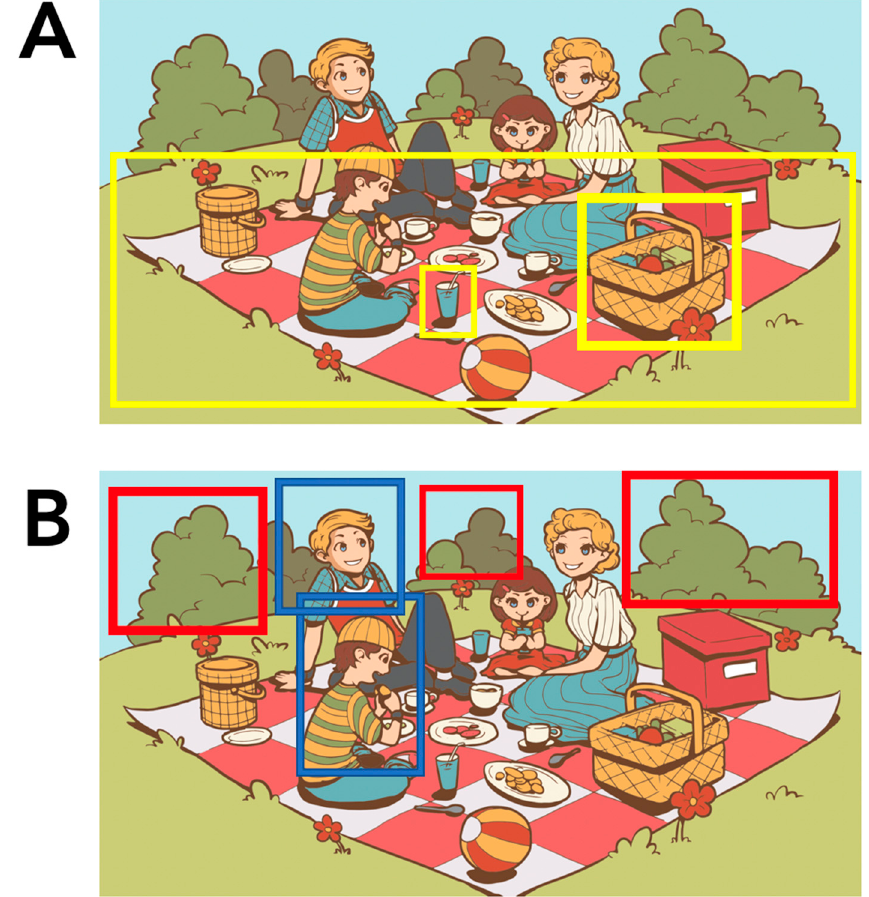
Figure 1. Identifying the range of ambiguity of elements in the Western Aphasia Battery-Revised (WAB-R) “Picnic Scene” task (Kertesz, 2007) [34]. In the study, the original WAB-R Picnic Scene was used, but due to permissions issues, here, we use a freely available picture to illustrate non-exhaustive examples of the range of ambiguity of possible referents in a picture description task. ( A ) The examples highlighted here (CU #24 “glass,” CU #25 “blanket”, CU #30 “basket”) are unambiguous entities similar to the ones found within the WAB-R Picnic Scene; ( B ) The examples highlighted here (CU #44 “shrubbery” (red) and CU #45 “fellow” (blue)) demonstrate the possible range of referents some CUs may represent. The image utilized for this example is freely available and reproduced with permission from Vecteezy